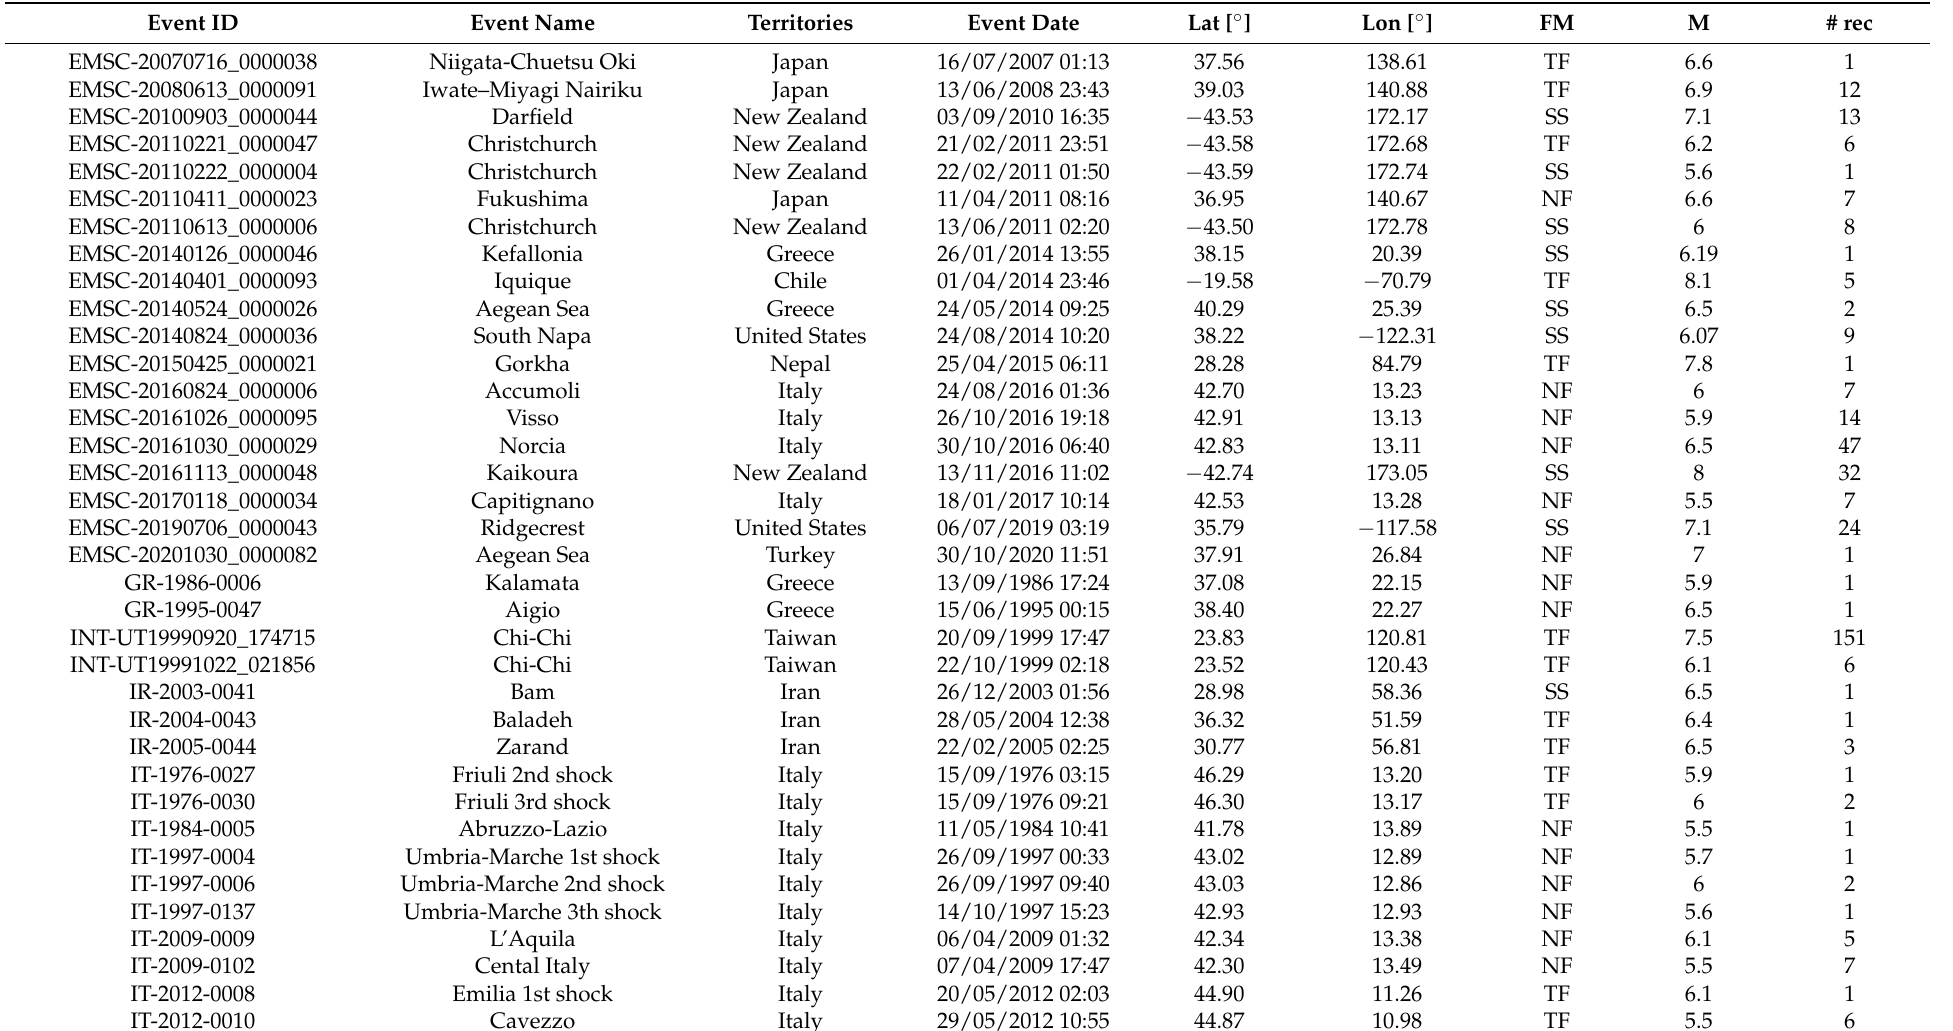
Table 1. Earthquakes selected for the fling-step